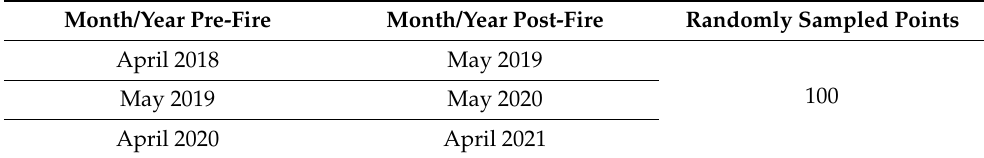
Table 1. Dates used in the study of pre-fire and post-fire dates and their respective randomly sampled